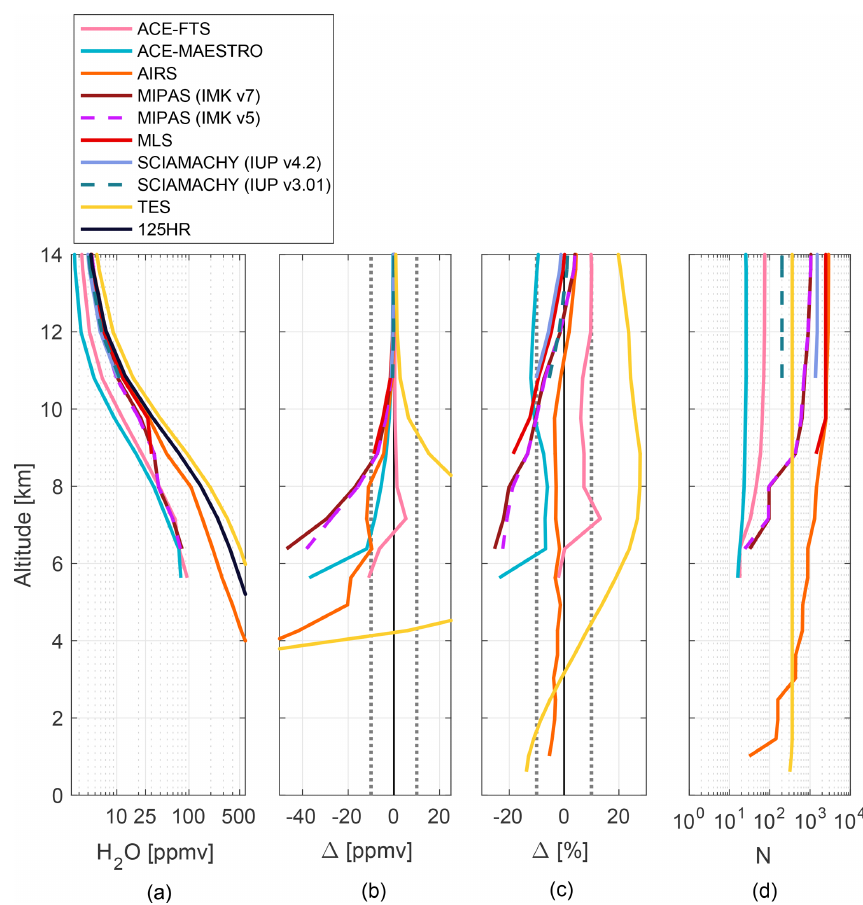
Figure 6. Summary of differences between satellite measurements and PEARL 125HR. (a) The mean of profiles used in the comparison. (b) The mean VMR difference between the satellite profiles and the 125HR profiles, using Eq. (4). (c) The mean percent difference between the satellite profiles and the 125HR profiles, using Eq. (5). (d) The number of coincident profile pairs contributing to the comparison at each altitude level. Grey dotted lines in (b) and (c) show ± 10ppmv and ± 10%, respectively. Note that the x axes for panels (a) and (d) are on a log